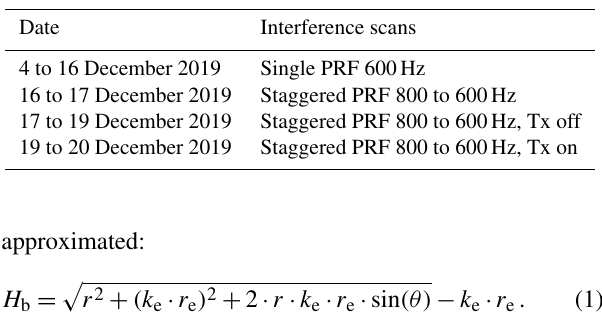
Table 4. Radar MHP test configurations from 6–20 December 2019.